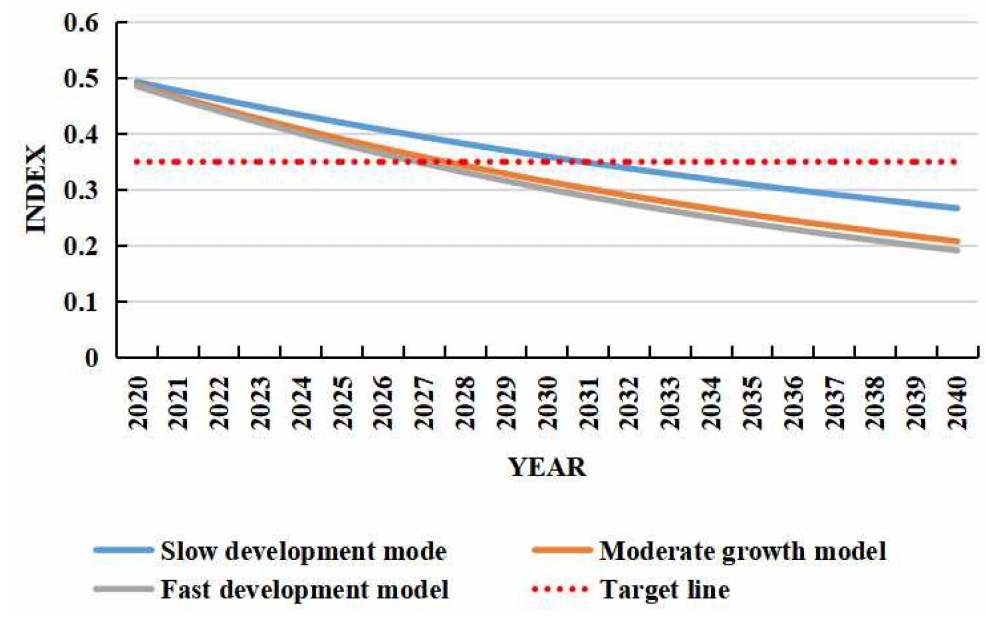
Figure 2. Changes of carbon emission in Anhui